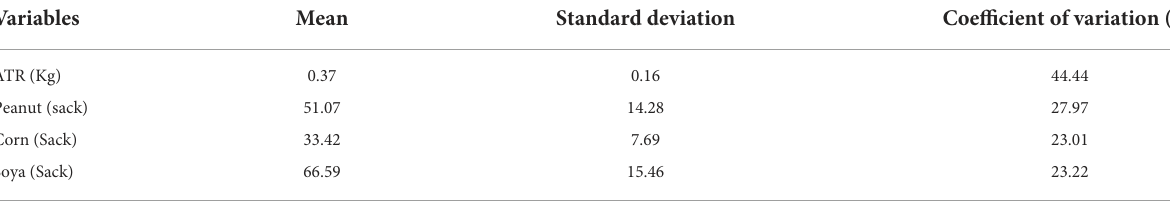
TABLE 3 Mean price, standard deviation and coefficient of variation for prices of studied variables. Variables Mean